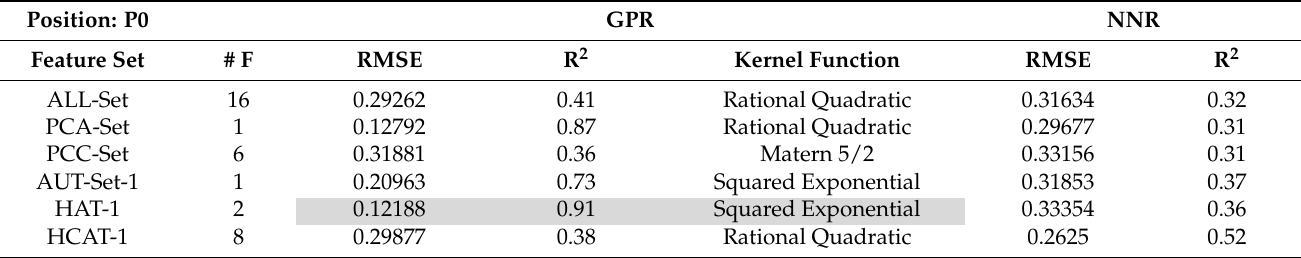
Figure 5. Autoencoder performance during the training process with N = 1 for ( A ) P0, ( B ) P1. Table 9. SWH_KU_CAL prediction performance of GPR and NNR models trained on KU-based feature combination sets for Position P0; Best models are highlighted in dark gray, and the second-best performance regressor is highlighted in light gray; ‘#’ denotes the number of